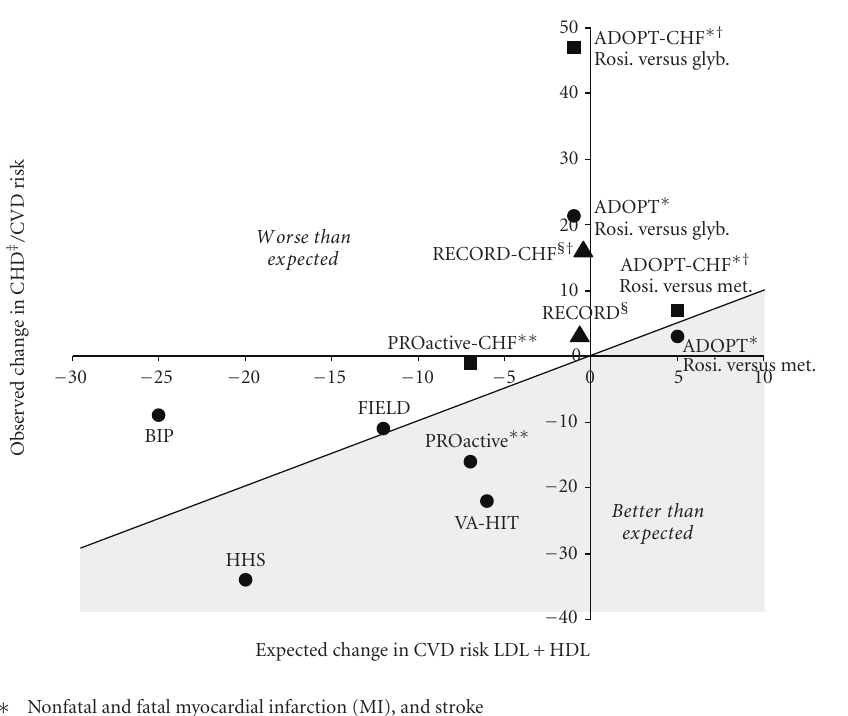
Figure 1: Approximate expected cardiovascular (CVD) risk reduction from percent changes in LDL and HDL versus observed percent reduction in coronary heart disease (CHD) or CVD. Above the slope = 1 line, CVD risk reduction was worse than expected based on lipid changes; below the slope = 1 line, CVD risk reduction was greater than expected based on the lipid